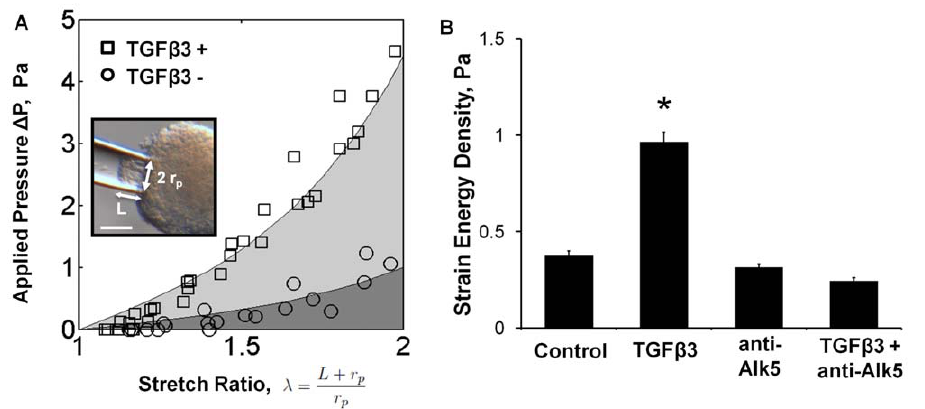
Figure 1. TGF b 3 treatment increases stiffness of AV cushions through Alk5 mediated pathway. A ) Representative pipette test data for TGF b 3 (1 ng/ml, TGF b 3 + ) and control media (TGF b 3 2 ) treated cushions, n=4. Strain energy density was calculated from the shaded regions beneath the D P vs l curves. Inset: image of aspirated HH25 AV cushion after 24 hours of culture. The pipette radius, r p , and the aspirated length, L are indicated. Scale bar=70 m m. B ) AV cushion strain energy density increased with TGF b 3 treatment, but was blocked by Alk5 inhibition